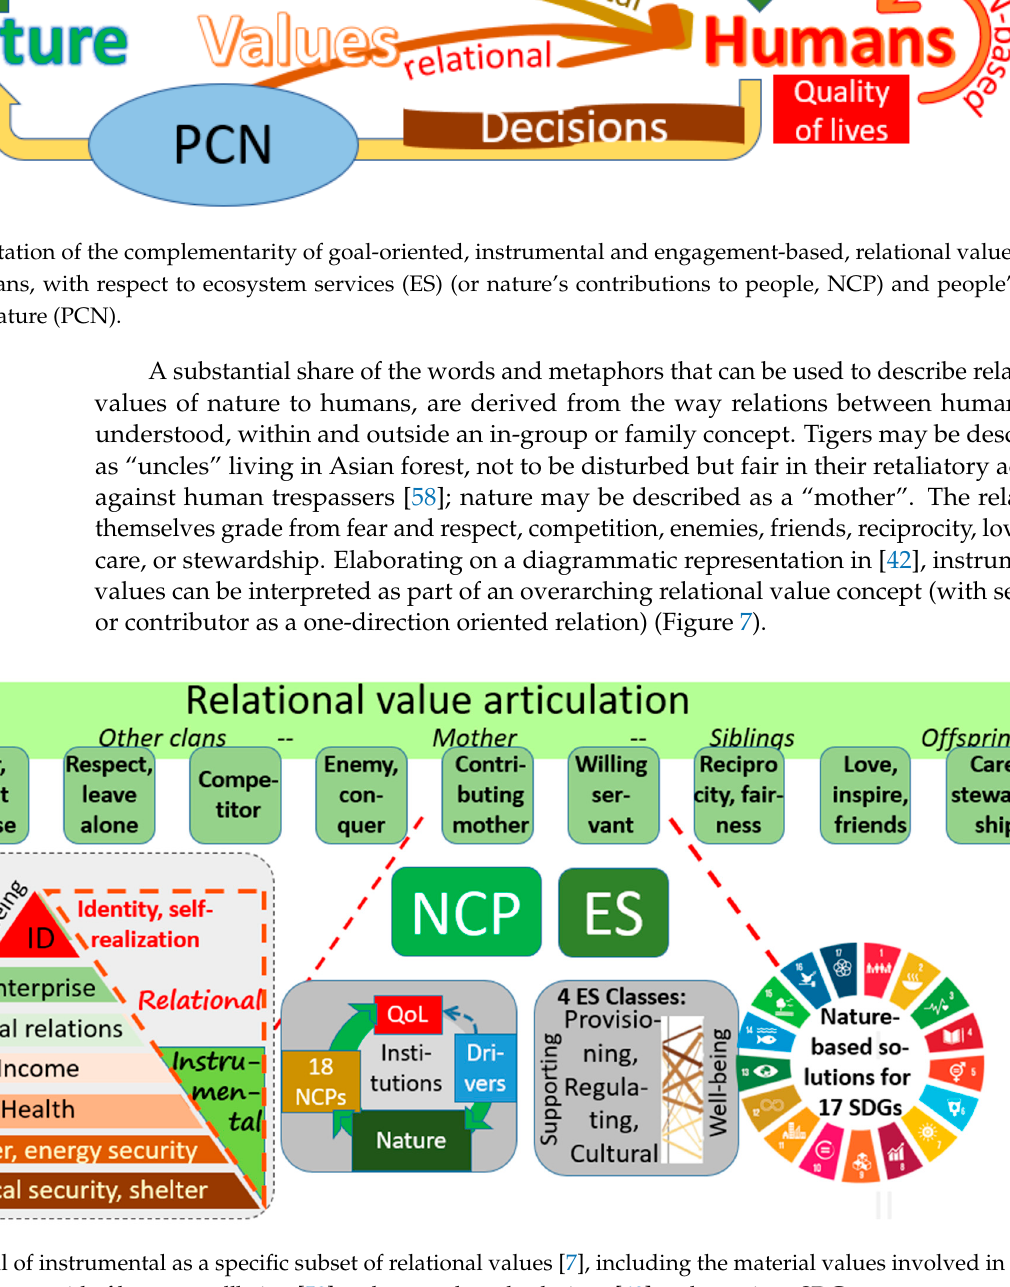
Figure 7. Portrayal of instrumental as a specific subset of relational values [7], including the material values involved in a modified Maslow pyramid of human wellbeing [59] and nature-based solutions [60] to the various SDGs.